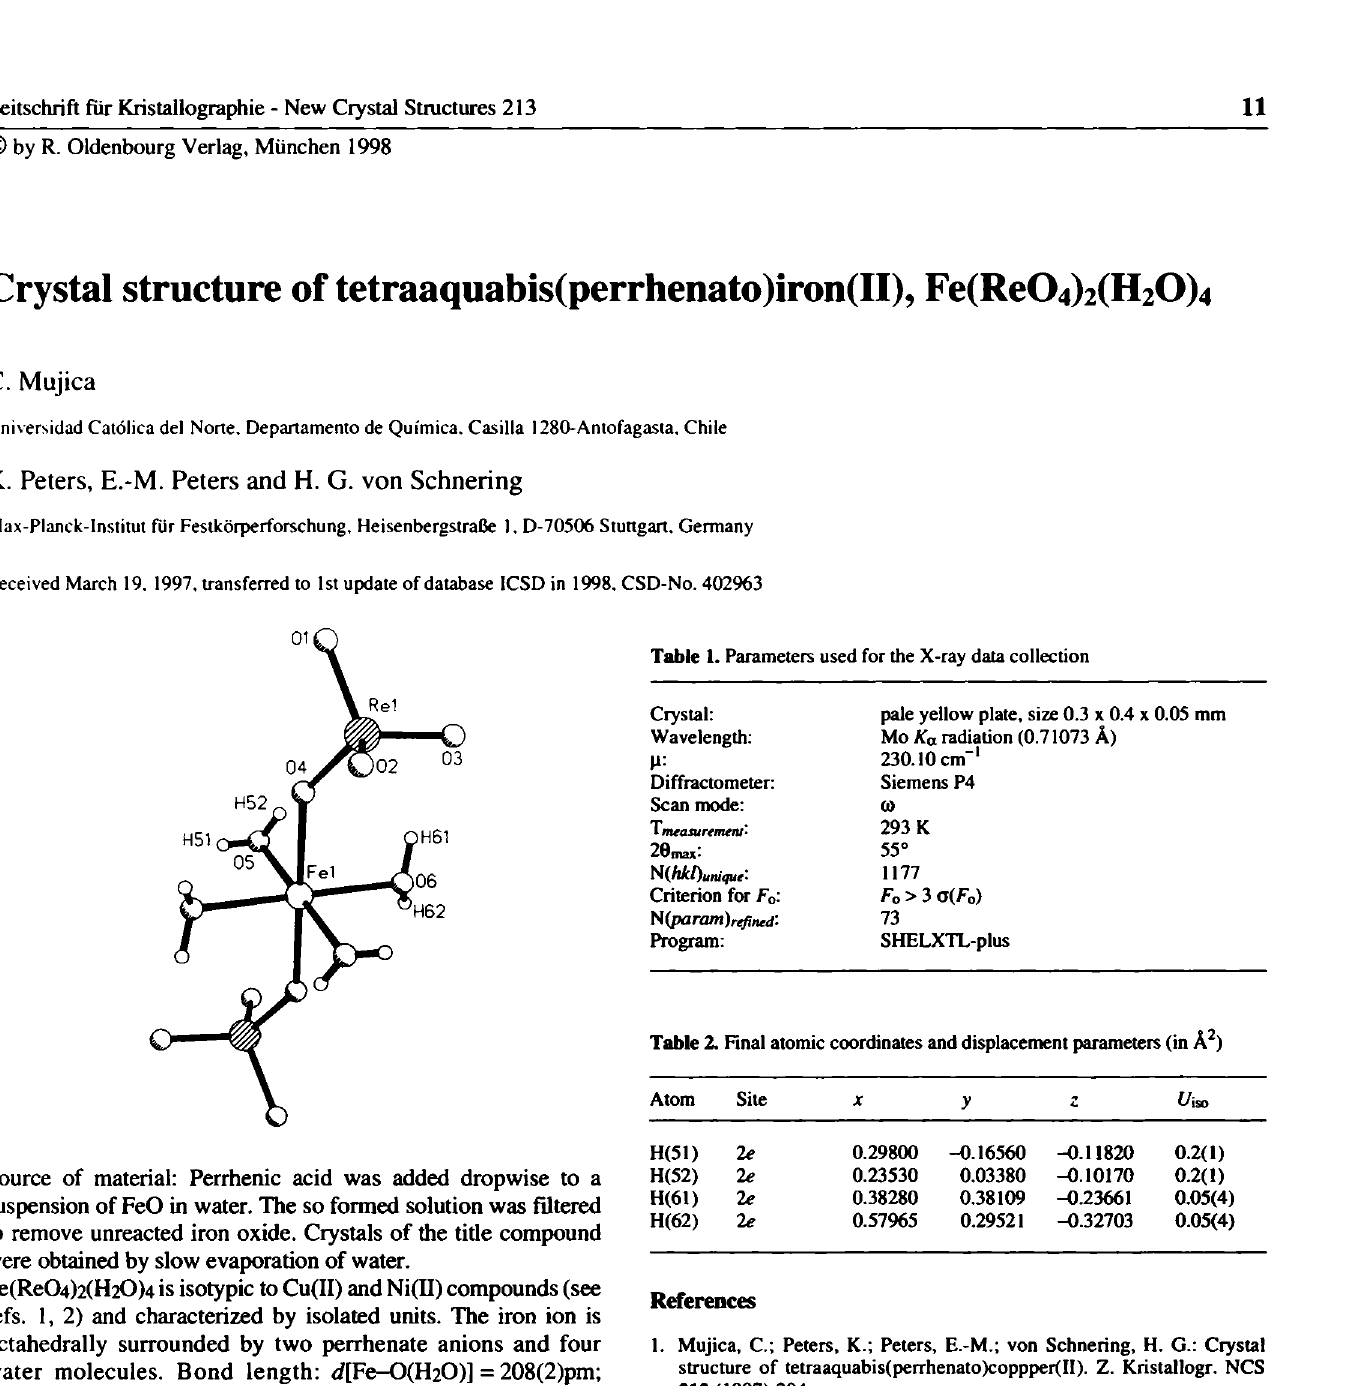
Table 3. Final atomic coordinates and displacement parameters (in Â^)